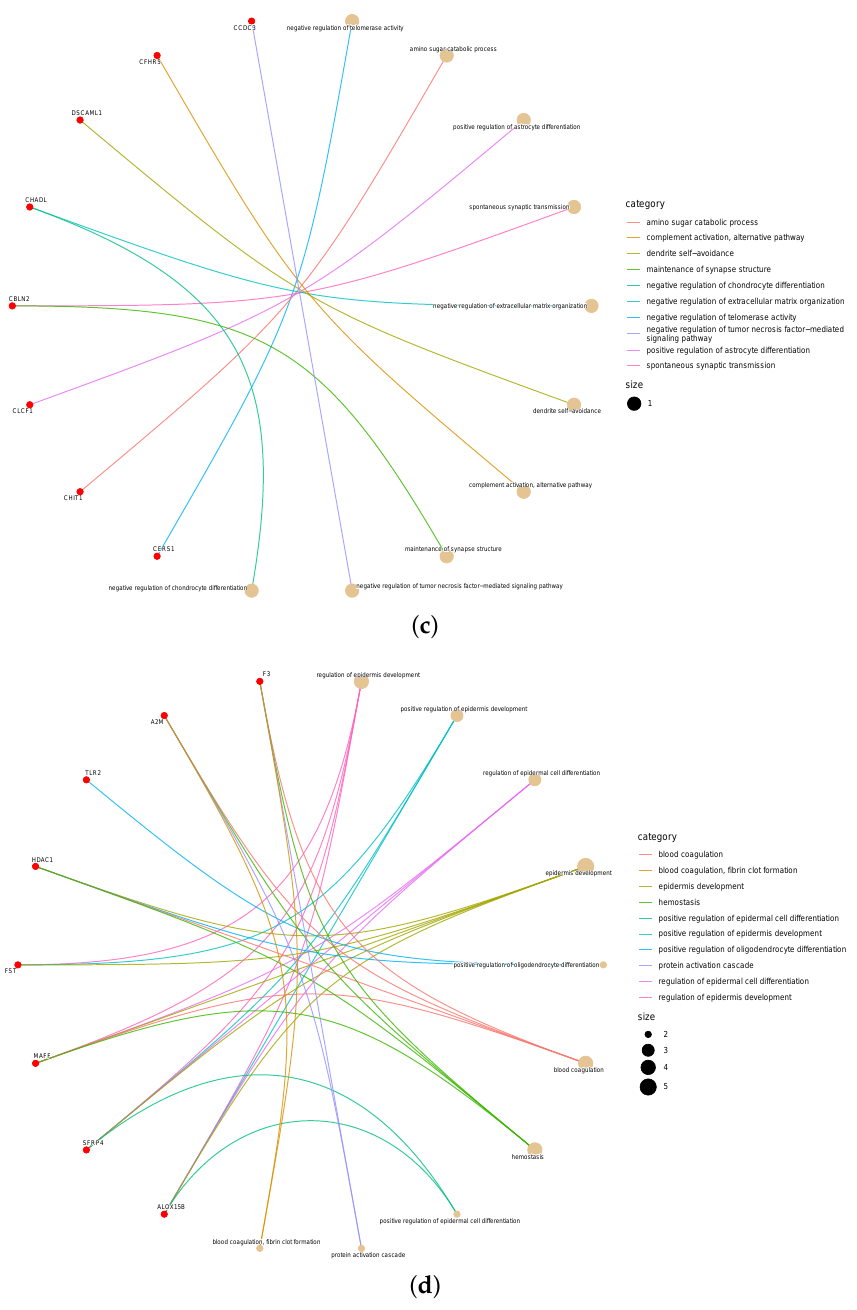
Figure 5. The gene–concept network depicts the linkages of genes and biological concepts as a network. ( a ) BRCA (breast cancer), ( b ) CESC (cervical carcinoma cancer), ( c ) COAD (colorectal cancer), and ( d ) PAAD (pancreas